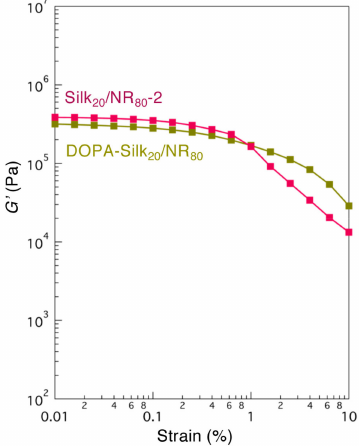
Figure 11. The strain dependence of G’ of silk 20 / NR 80 -2 and DOPA-silk 20 / NR 80 . The frequency was fixed at 10